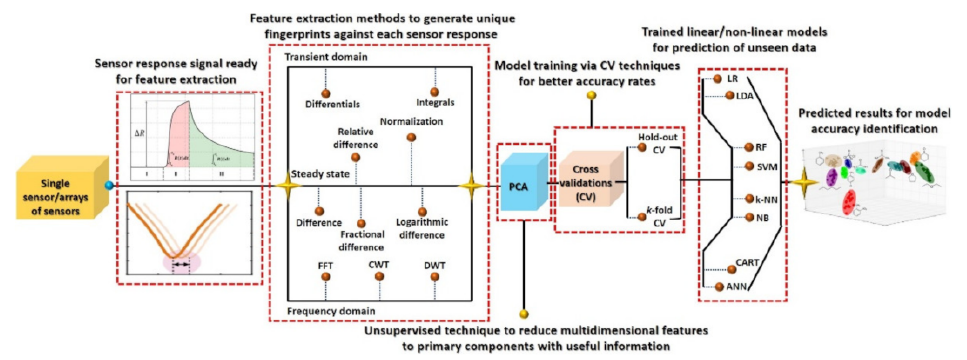
Figure 10. Overall machine learning process from sensors response, data processing, and model training to prediction